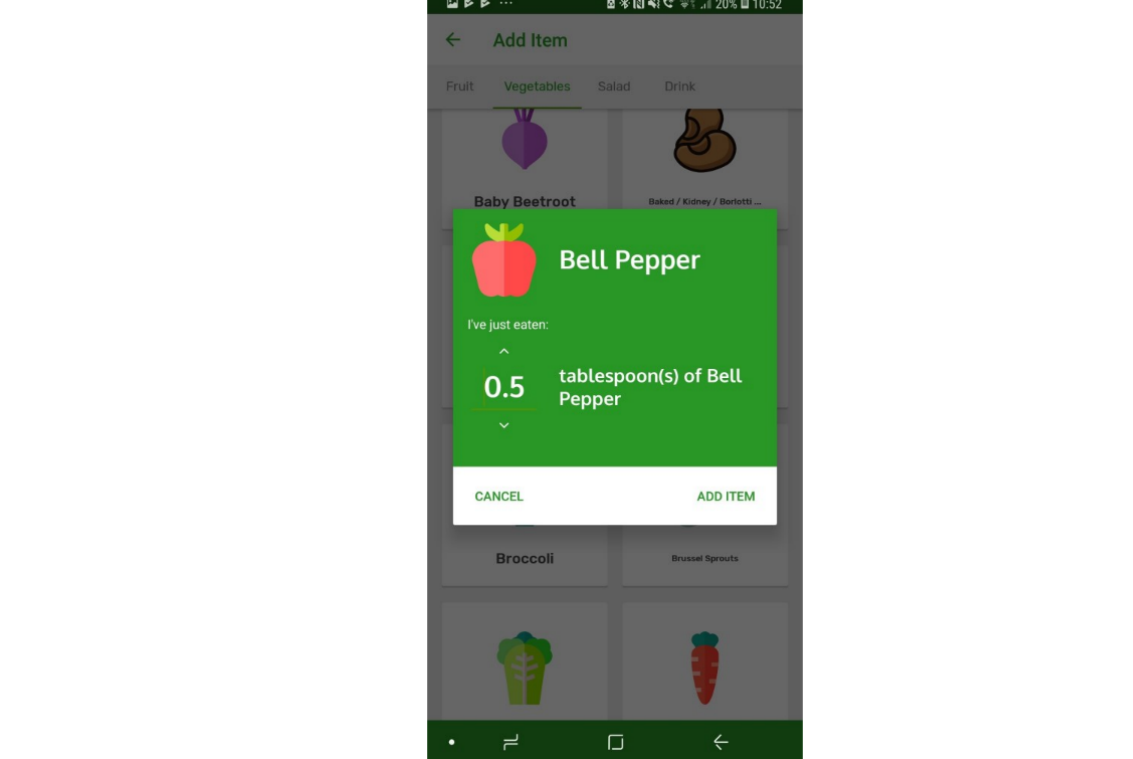
Figure 4. Screenshots of the app: fruit and vegetable selection.